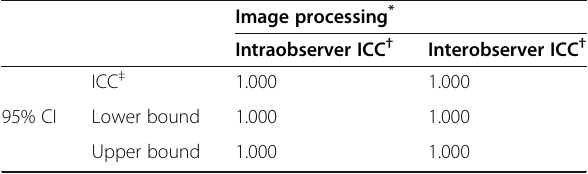
Table 2 Intra- and interobserver reliability in the first step of image analysis